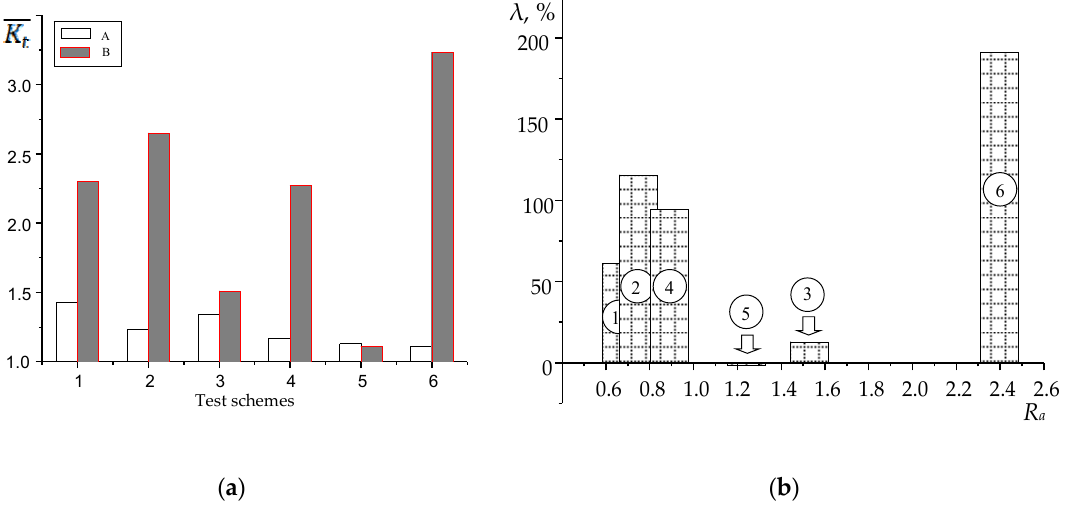
Figure 3. Stress concentration factors of the initial and damaged specimen surface from steel 20: ( a ) K t under different test schemes, ( b ) dependence of relative effective coefficient of stress concentration ( λ ) from roughness parameter R a .